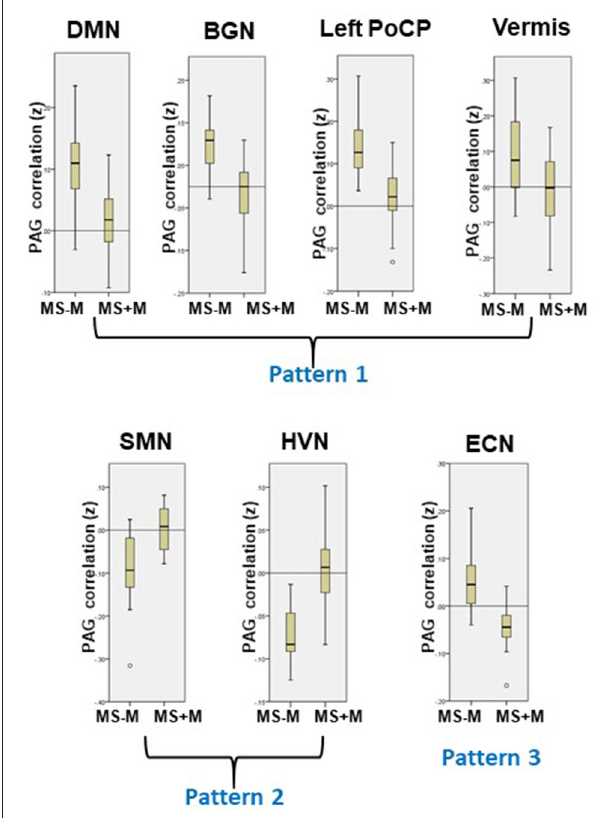
FIGURE 3 | Patterns of PAG RS-FC changes in MS + M patients. Three dissociable patterns of correlation changes emerged from the PAG-based connectivity analysis (see also Table 3 ): Pattern 1 includes regions with PAG positive connectivity loss (DMN, BGN, left PoCP, and cerebellar Vermis); Pattern 2 includes regions with PAG negative correlation loss (SMN and HVN); Pattern 3 was characterized by loss of PAG positive and development of PAG negative connectivity (ECN). The yellow boxes show the RS-FC values distribution, for each region exhibiting significant differences with respect to MS-M (see also Figure 2